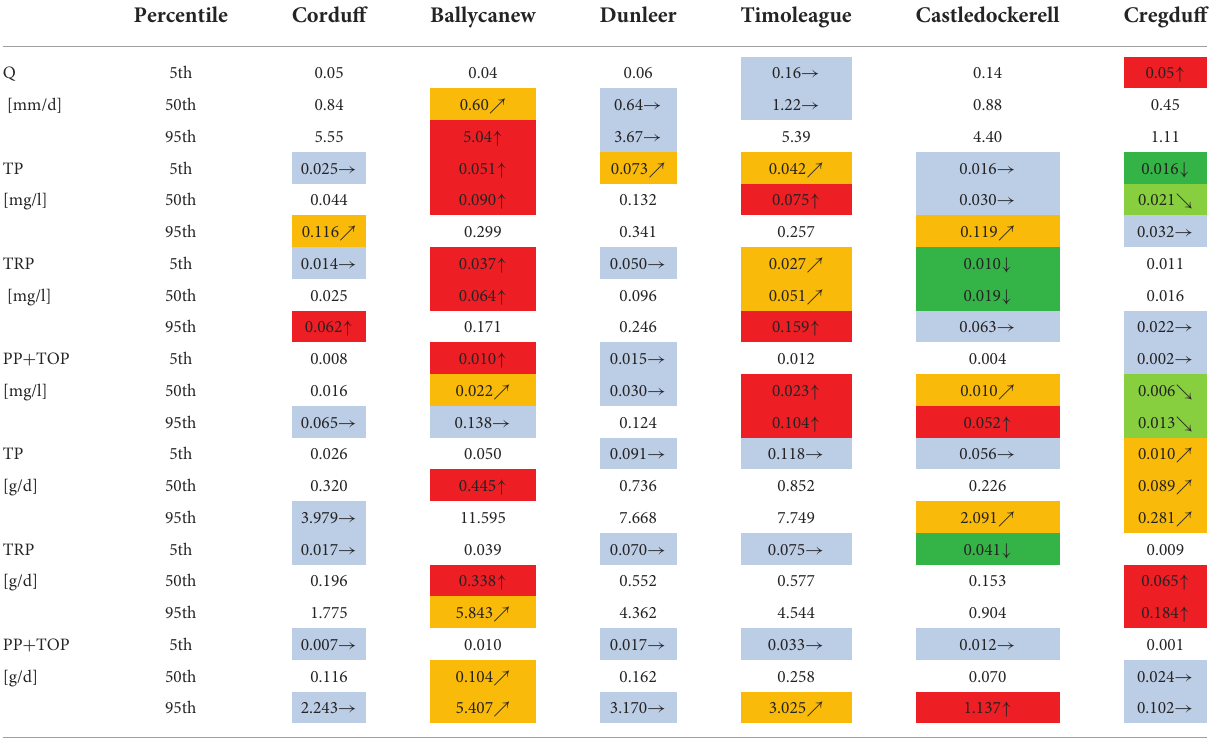
TABLE 3 The 5th, 50th, and 95th PCTL of river discharge, P concentrations and P mass loads for the six study catchments.